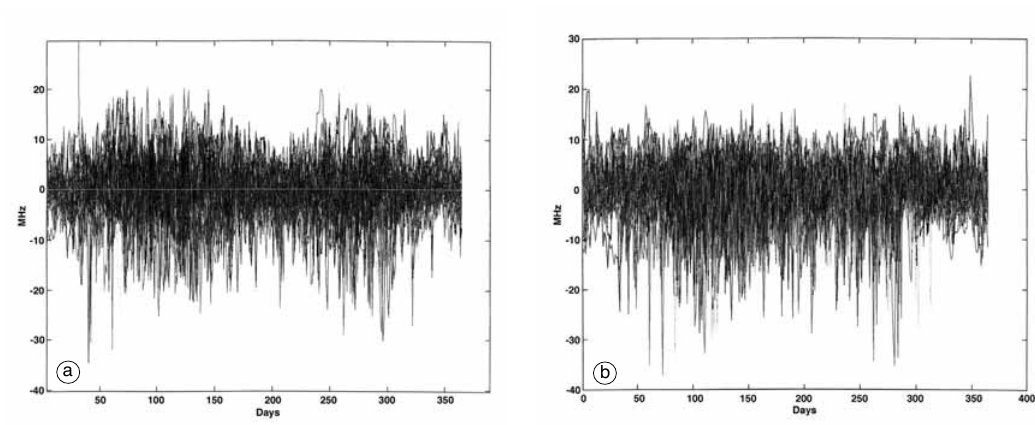
Fig. 7a,b. Yearly variation of the positive and negative deviations for Uppsala (high latitude) and Rome (low